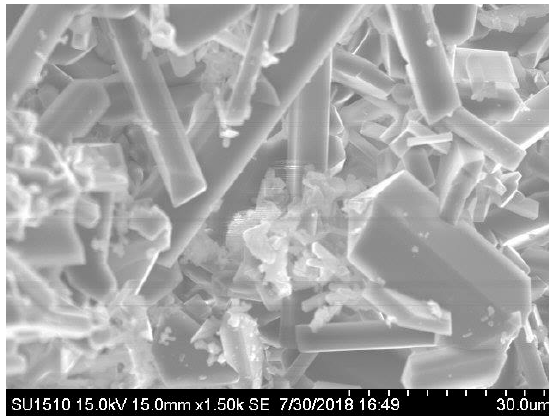
Figure 10. XRD analysis.